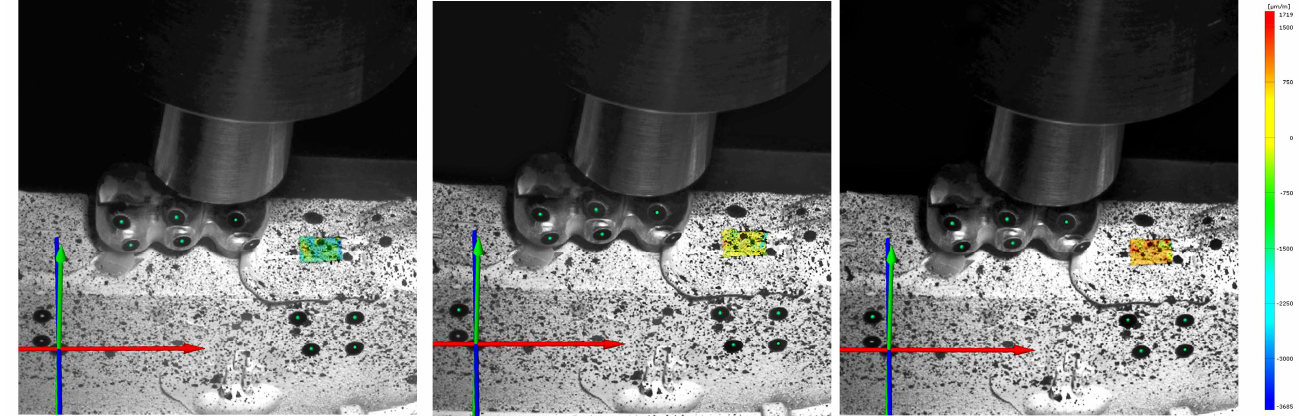
Figure 2. Experimental setup showing the frontal surface with superstructure as well as the optical measuring surface above strain gauge 1 at increasing mastocatory forces from left to right.